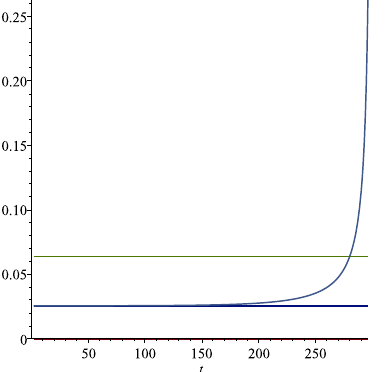
Figure 1. The optimal drawdown rate vs. expected return. T =